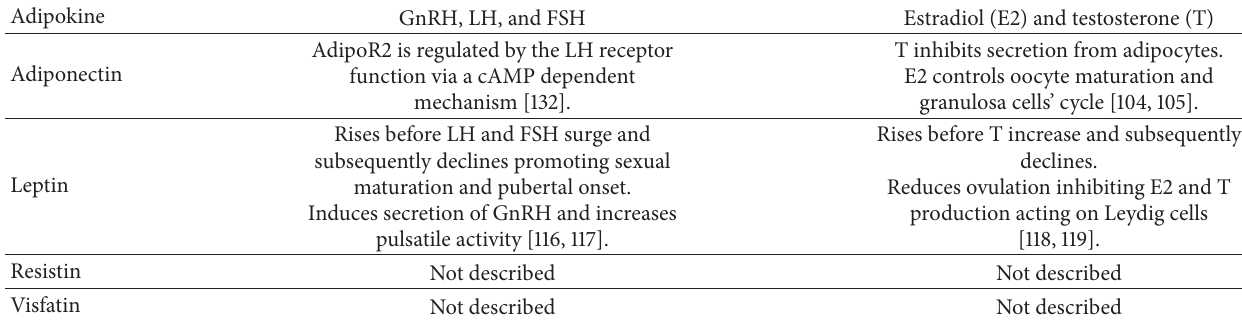
Table 3: Role of adipokines in